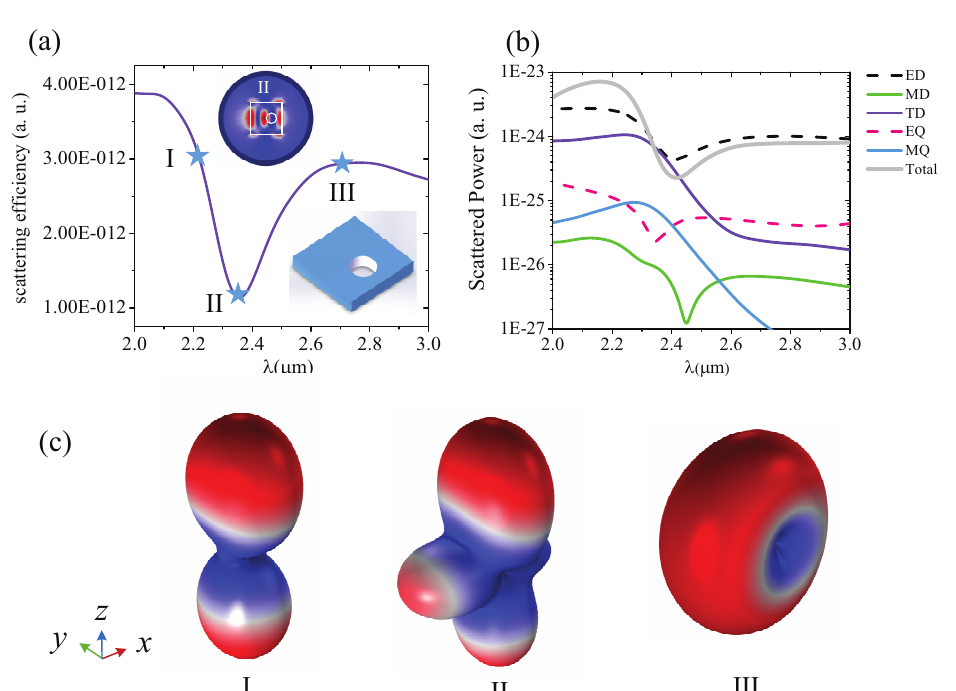
Figure A3. ( a ) Scattering efficiency of isolated nanodisk. The inset shows the electric field distribution of λ II = 2.35 µ m, where the corresponding parameter is L = 1200 nm, h = 220 nm, d = 200 nm. ( b ) Total scattered power and contributions of different multipoles. ( c ) Radiation patterns of differ- ent